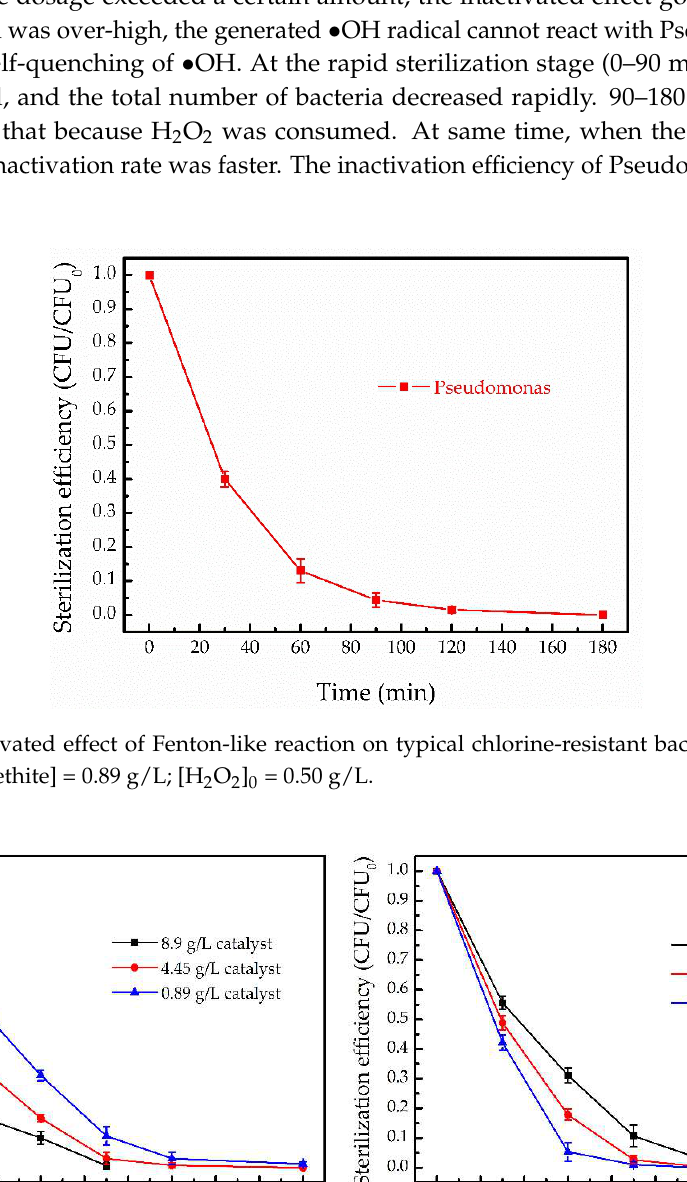
Table 4. Filtered water microorganisms.